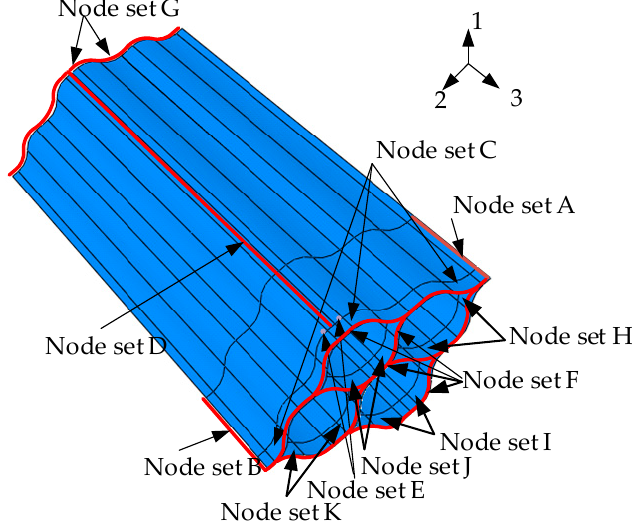
Figure 6. Node sets used in the FE model.